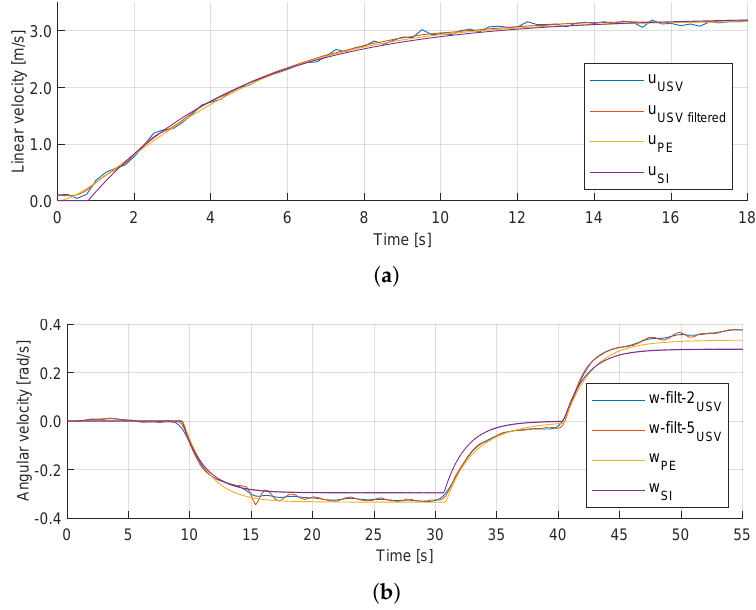
Figure 5. Comparison plot between SI tool, parameter estimation (PE) app, and field test data: ( a ) Surge motion. ( b ) Heading